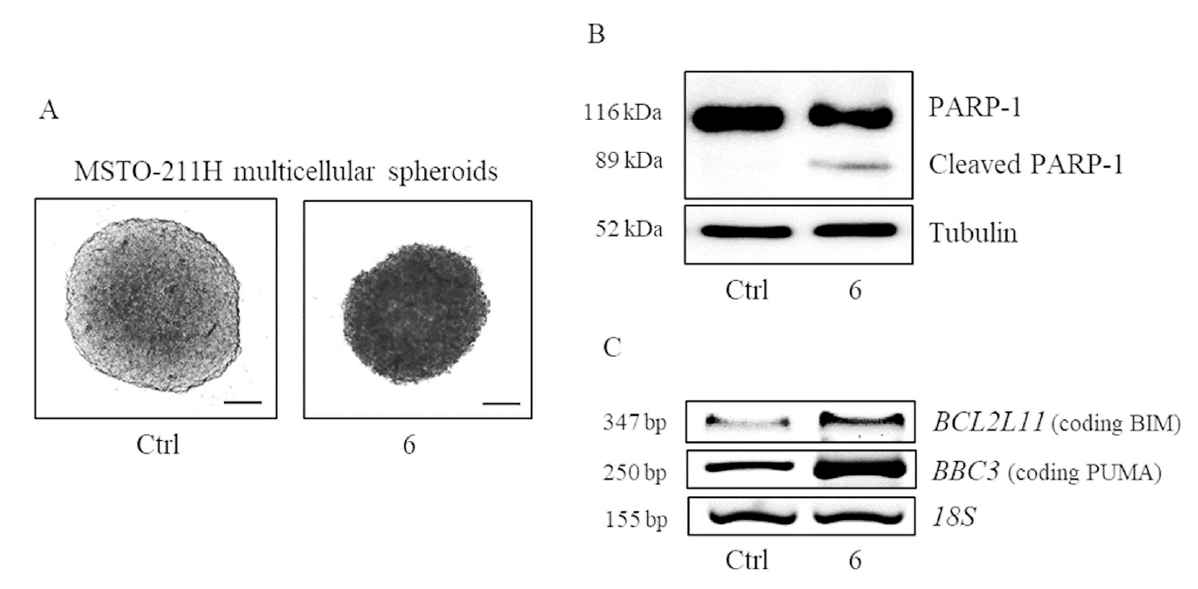
Figure 5. Compound 6 induces apoptosis in MSTO-211H multicellular spheroids (MCS). ( A ) Representative microscope images of MCS treated for 72 h with diluent (Ctrl) or 10 µ M 6 . Scale bar = 100 µ m. ( B ) Representative Western blot showing PARP-1 cleavage in MSTO-211H MCS treated with 6 . Tubulin was used as loading control. ( C ) RT-PCR showing induction of BCL2L11 and BBC3 in MSTO-211H MCS treated with 6 . 18S was used as housekeeping gene.